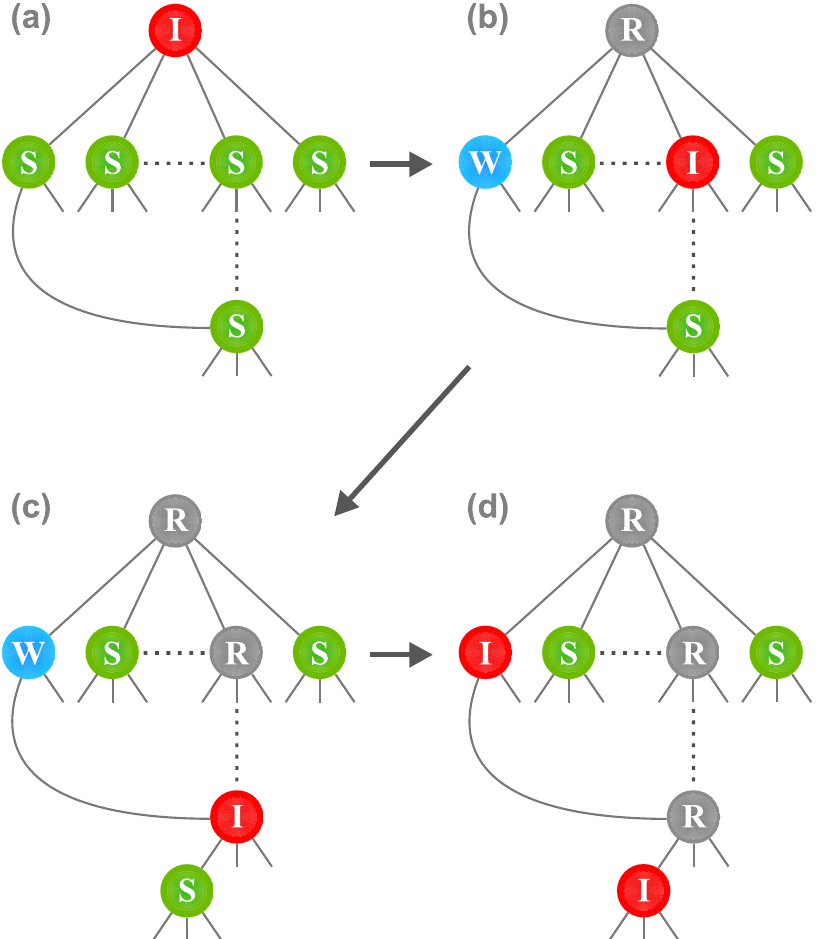
Figure 2. Schematic picture of the epidemic spreading process in the SWIR model. ( a ) The process begins from an infectious node. ( b ) It can infect a susceptible node among its neighbors and change the state thereof from S to I and can also change the state of another neighbor from S to W . This type of process persists for a long time and the critical branching tree is constructed. After a long O ( N 1/3 ) time passes, an infectious node can contact a node in state W that was created much earlier and change its state from W to I in ( d ). In addition, ( d ) the I-node in ( c ) infects a susceptible neighbor and changes its state to I . Thus, a SC process occurs, leading to the jump in the order parameter.